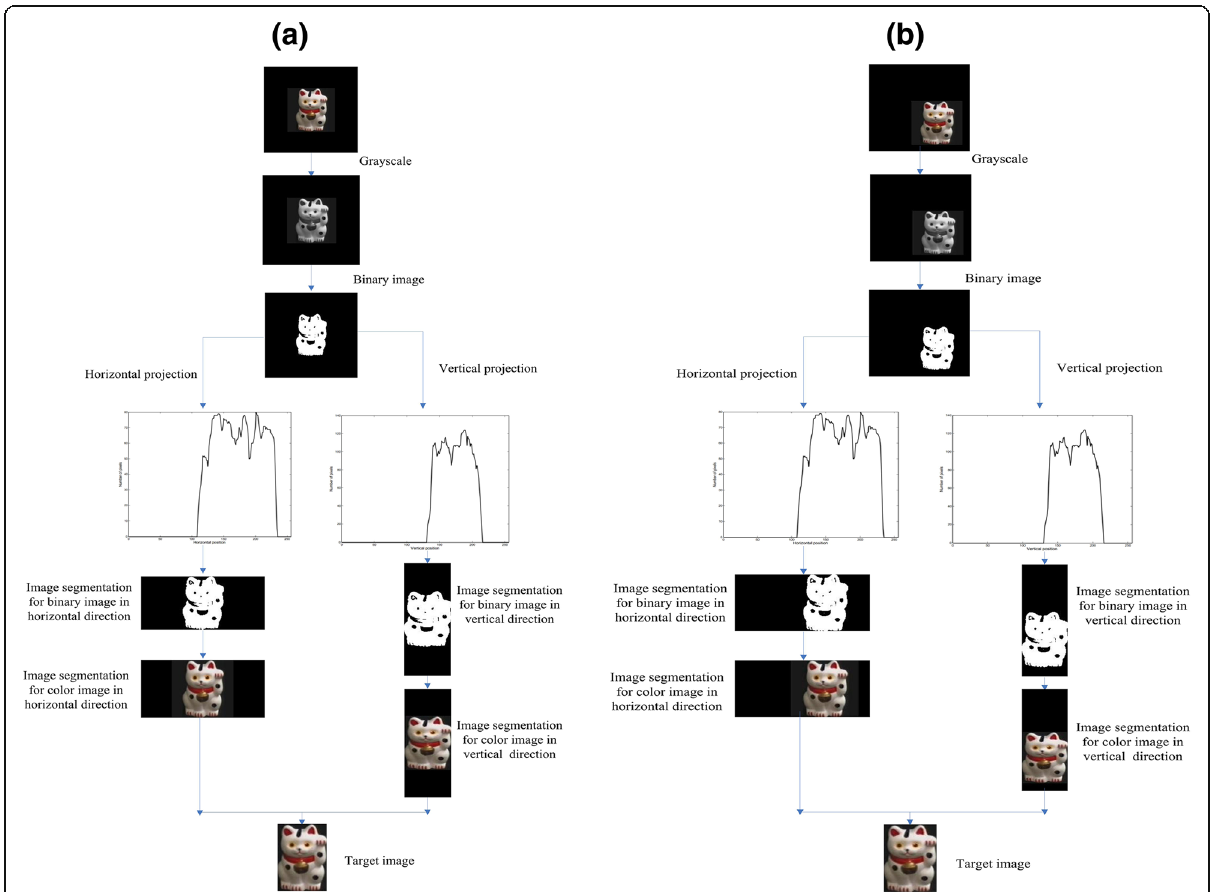
Fig. 15 a The projection approach for untranslated color image. b The projection approach for translated color